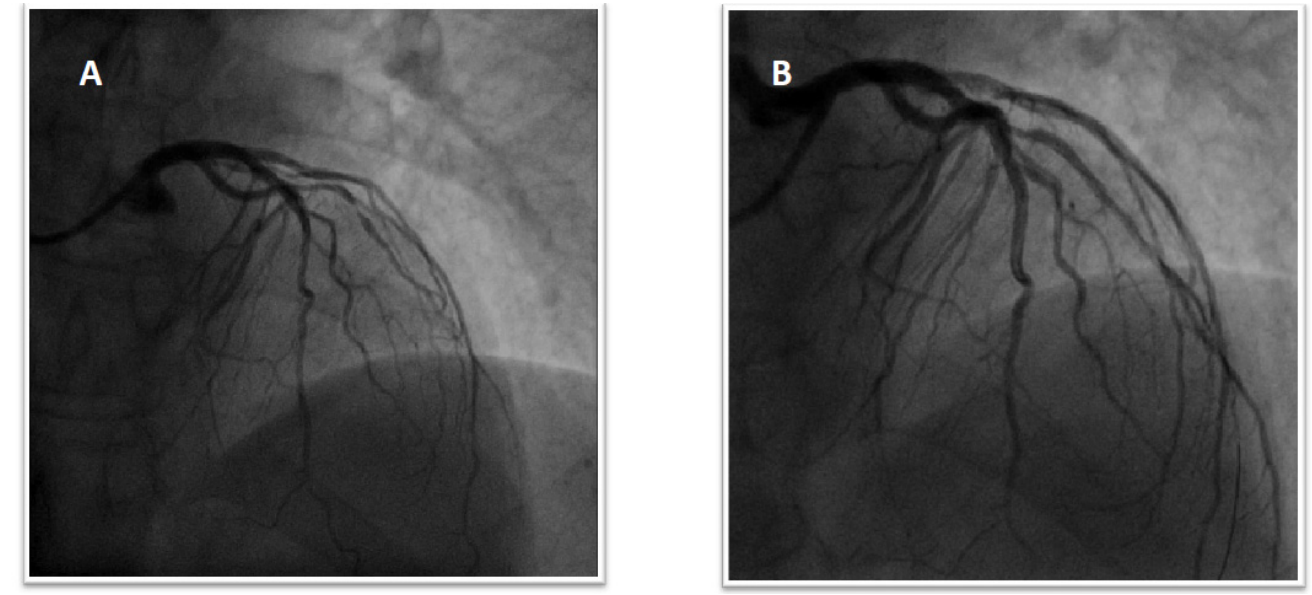
Figure 3. Angiogram showing critical stenosis of a large diagonal branch ( A ) treated with PCI and implantation of one DES (2.75 × 18 mm) ( B ).